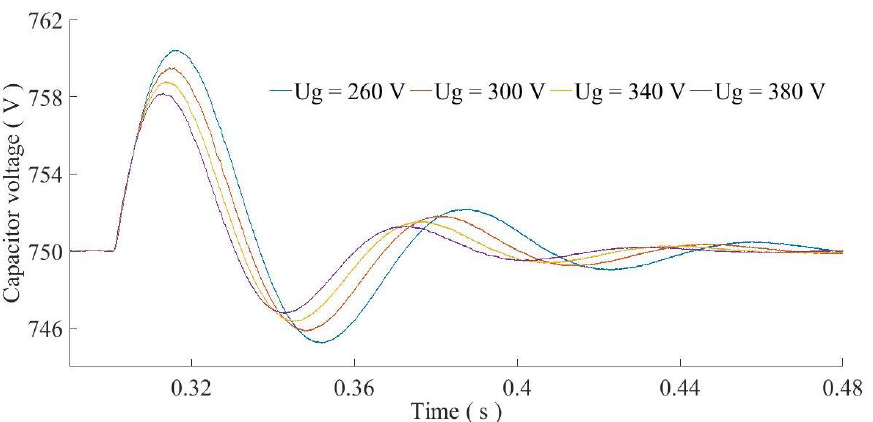
Figure 13. Influence of U g on the dynamic performance of the DDPS.